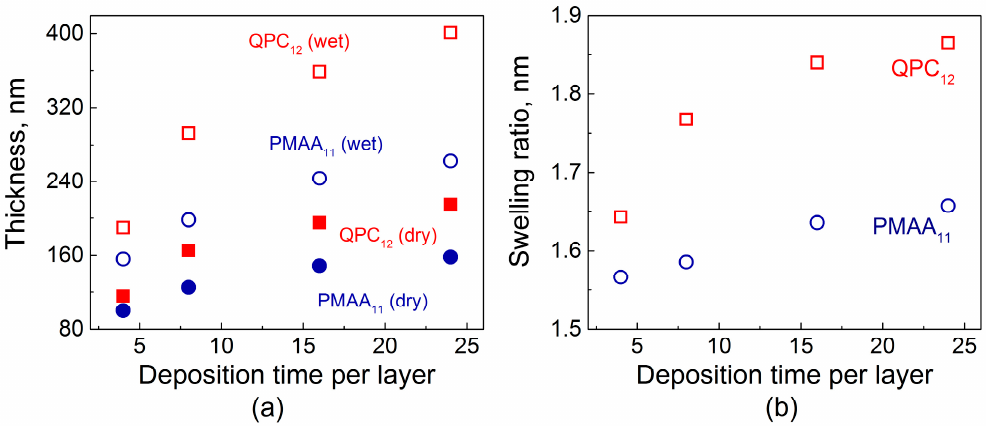
Figure 1. ( a ) Dry and in situ thicknesses of PMAA 11 (poly(methacrylic acid),red symbols) and QPC 12 (quaternized poly-2-(dimethylamino)ethyl methacrylate, blue symbols) films as a function of deposition time per layer; ( b ) Calculated swelling ratio of PMAA 11 (red symbols) and QPC 12 (blue symbols) films as a function of deposition time per layer .